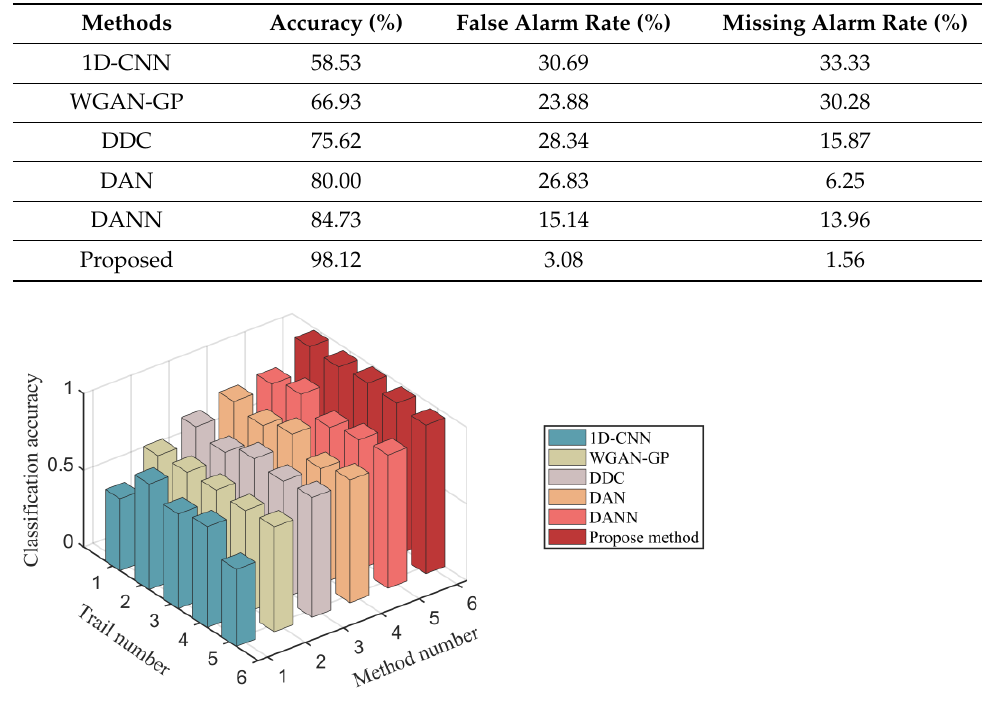
Figure 13. The classification accuracy comparison of multiple